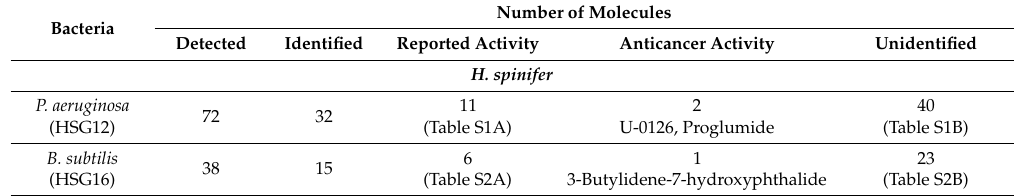
Table 2. The molecules detected, identified and unidentified from the conditioned media prepared from bacteria isolated from the gastrointestinal tract of H. spinifer through liquid chromatography–mass spectrometry (LC–MS). The conditioned media prepared were subjected to chloroform extraction